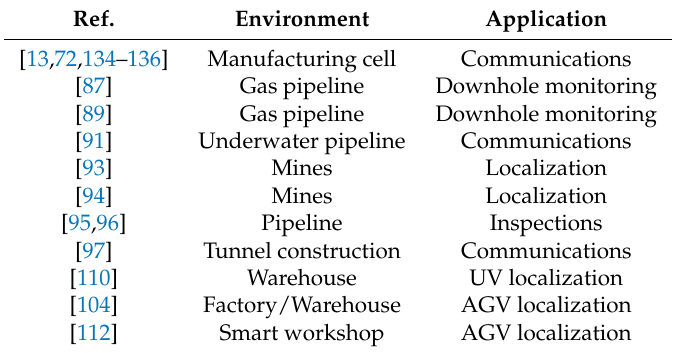
Table 4. A selection of some of the VLC work performed in different industrial settings.